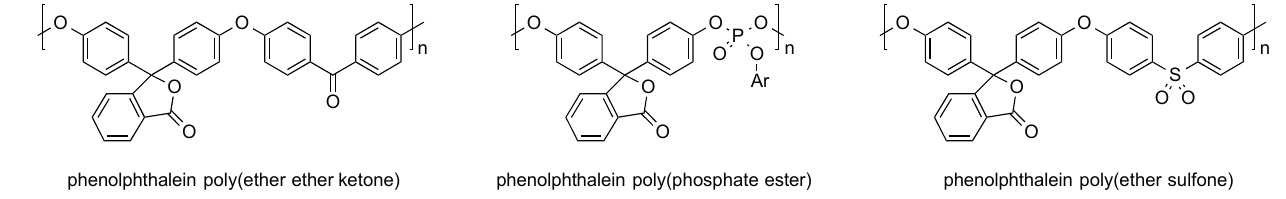
Figure 6. Examples of phenolphthalein-containing polymers obtained from polycondensation